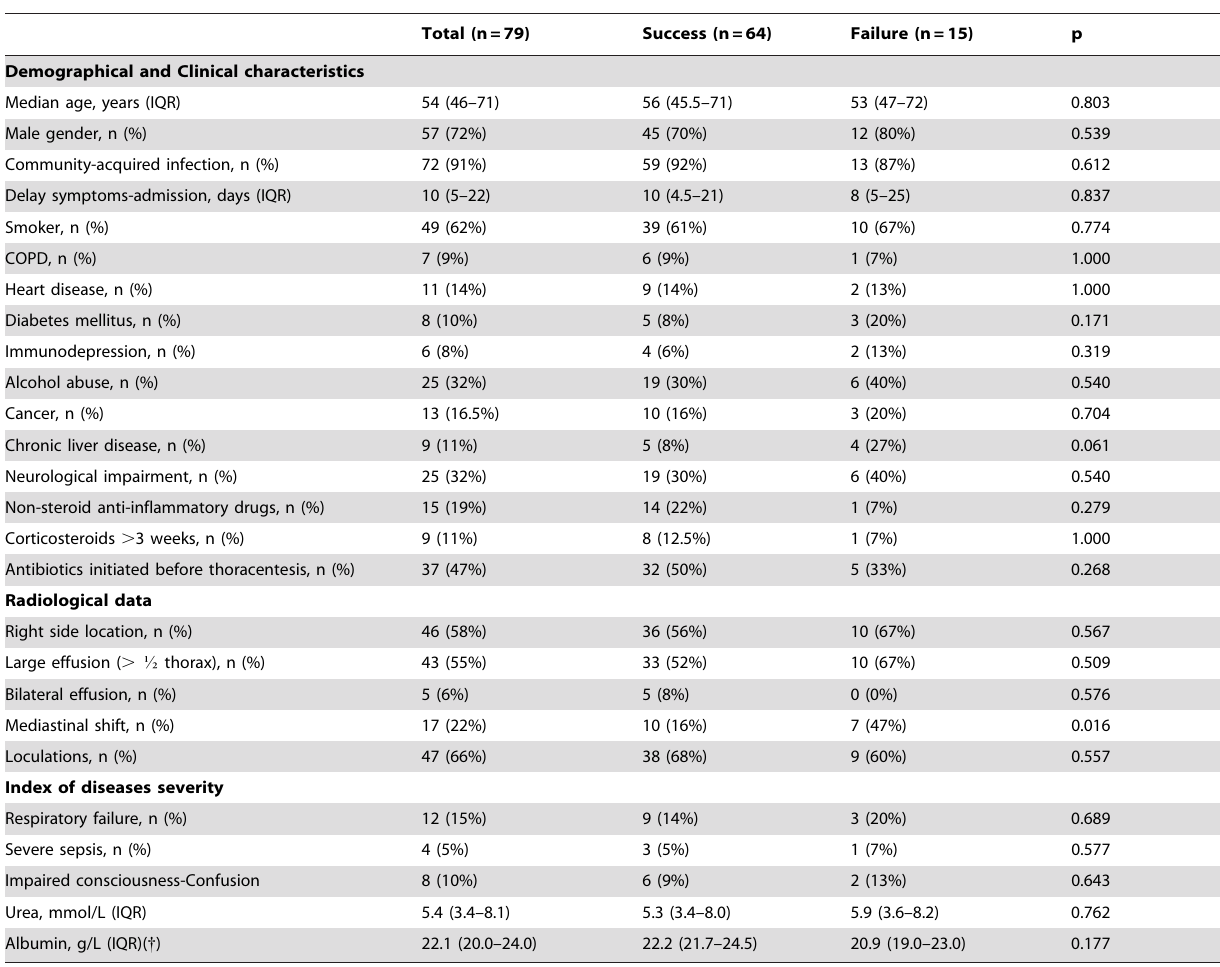
Table 1. Characteristics of